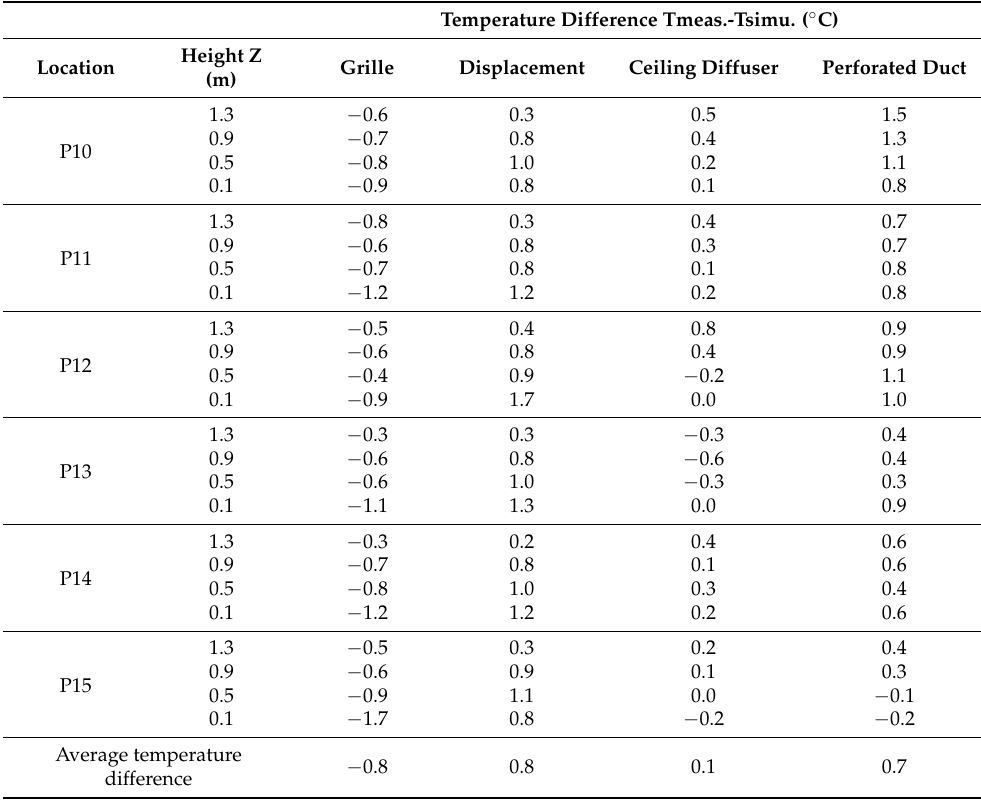
Table 3. Air temperature difference in the middle section A-A plane of classroom (Figure 2) in the summer with of half occupancy